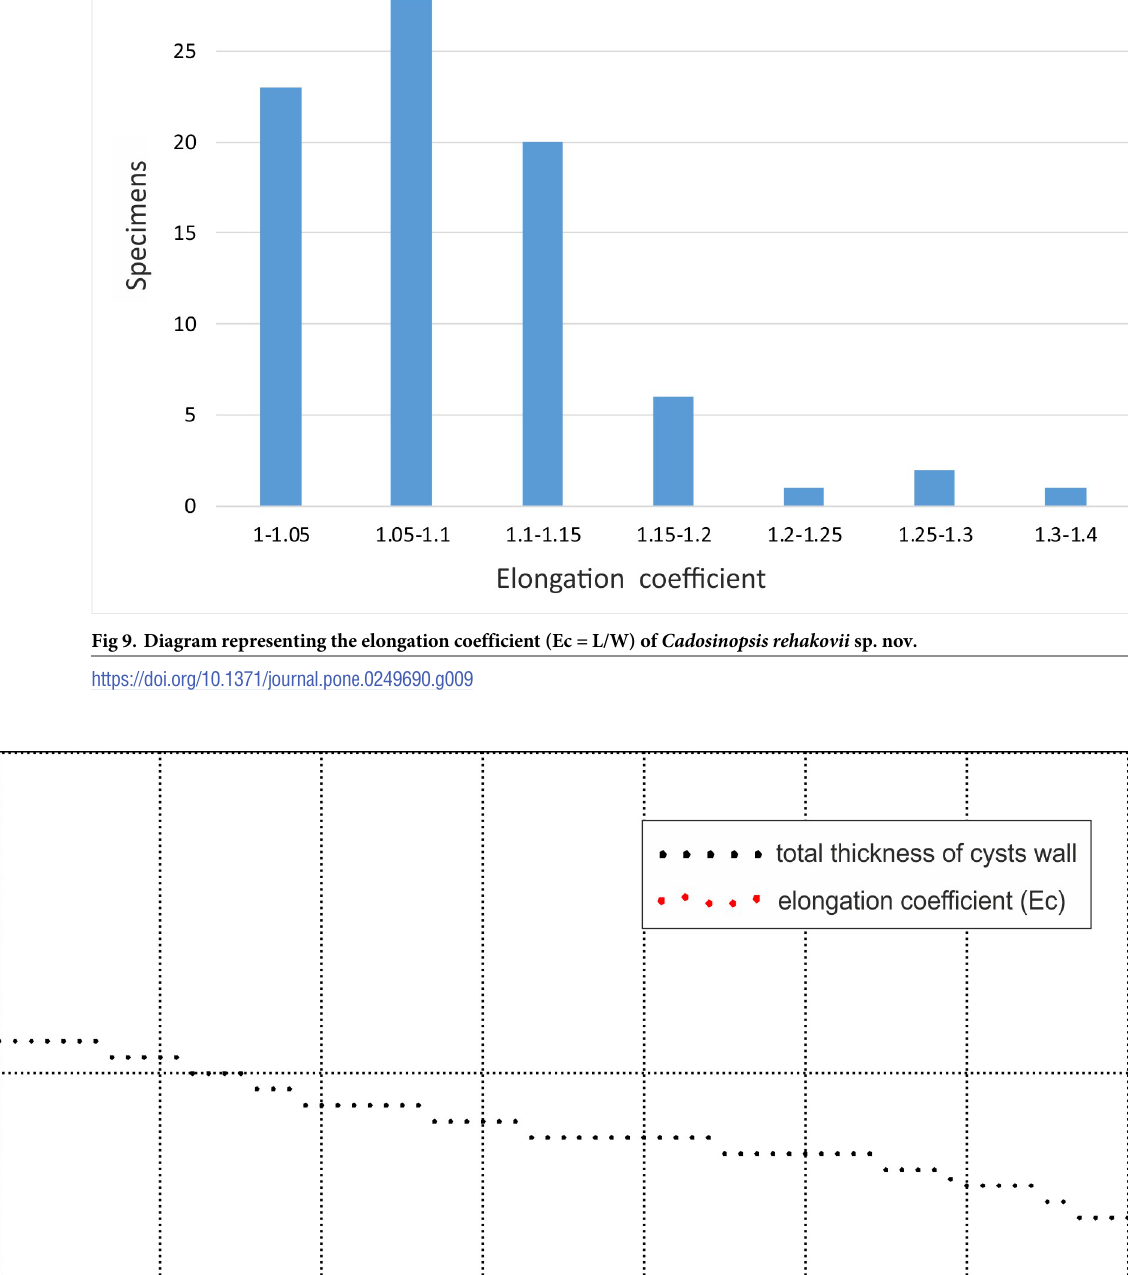
PLOS ONE | https://doi.org/10.1371/journal.pone.0249690 May 5,